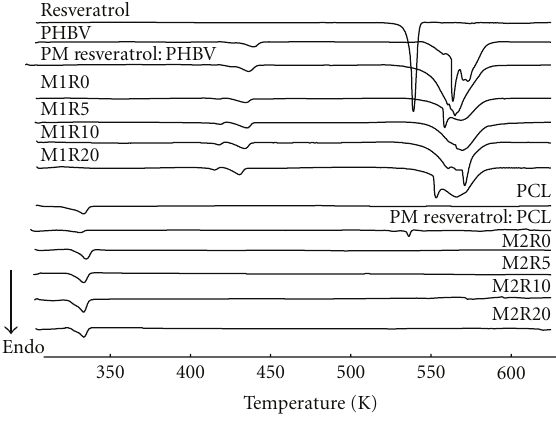
Figure 7: DSC curves of resveratrol, PHBV/PCL, physical mixtures, and PHBV/PCL